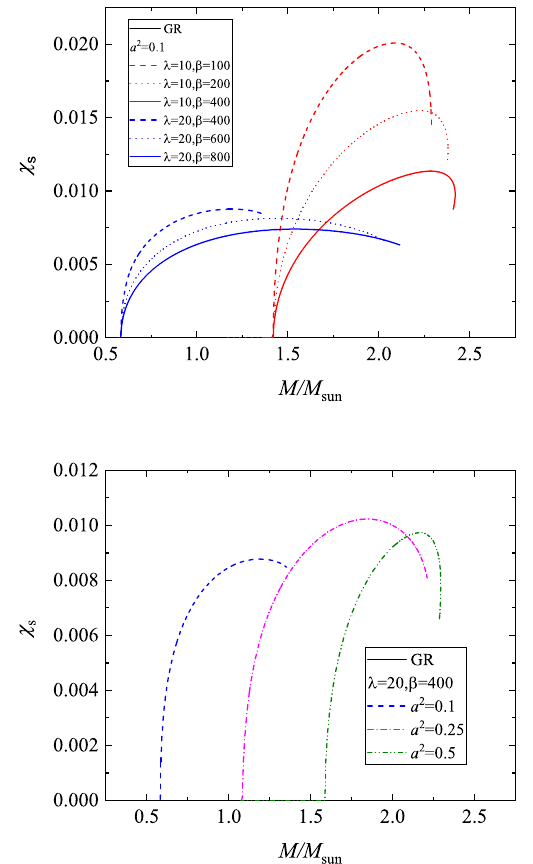
Fig. 3 The value of the scalar field on the surface of the star as a function of the mass of the star. Top: fixed value of a 2 and different values of λ and β . Bottom: fixed values of λ and β and different values of a 2 . The mass of the star is in solar masses